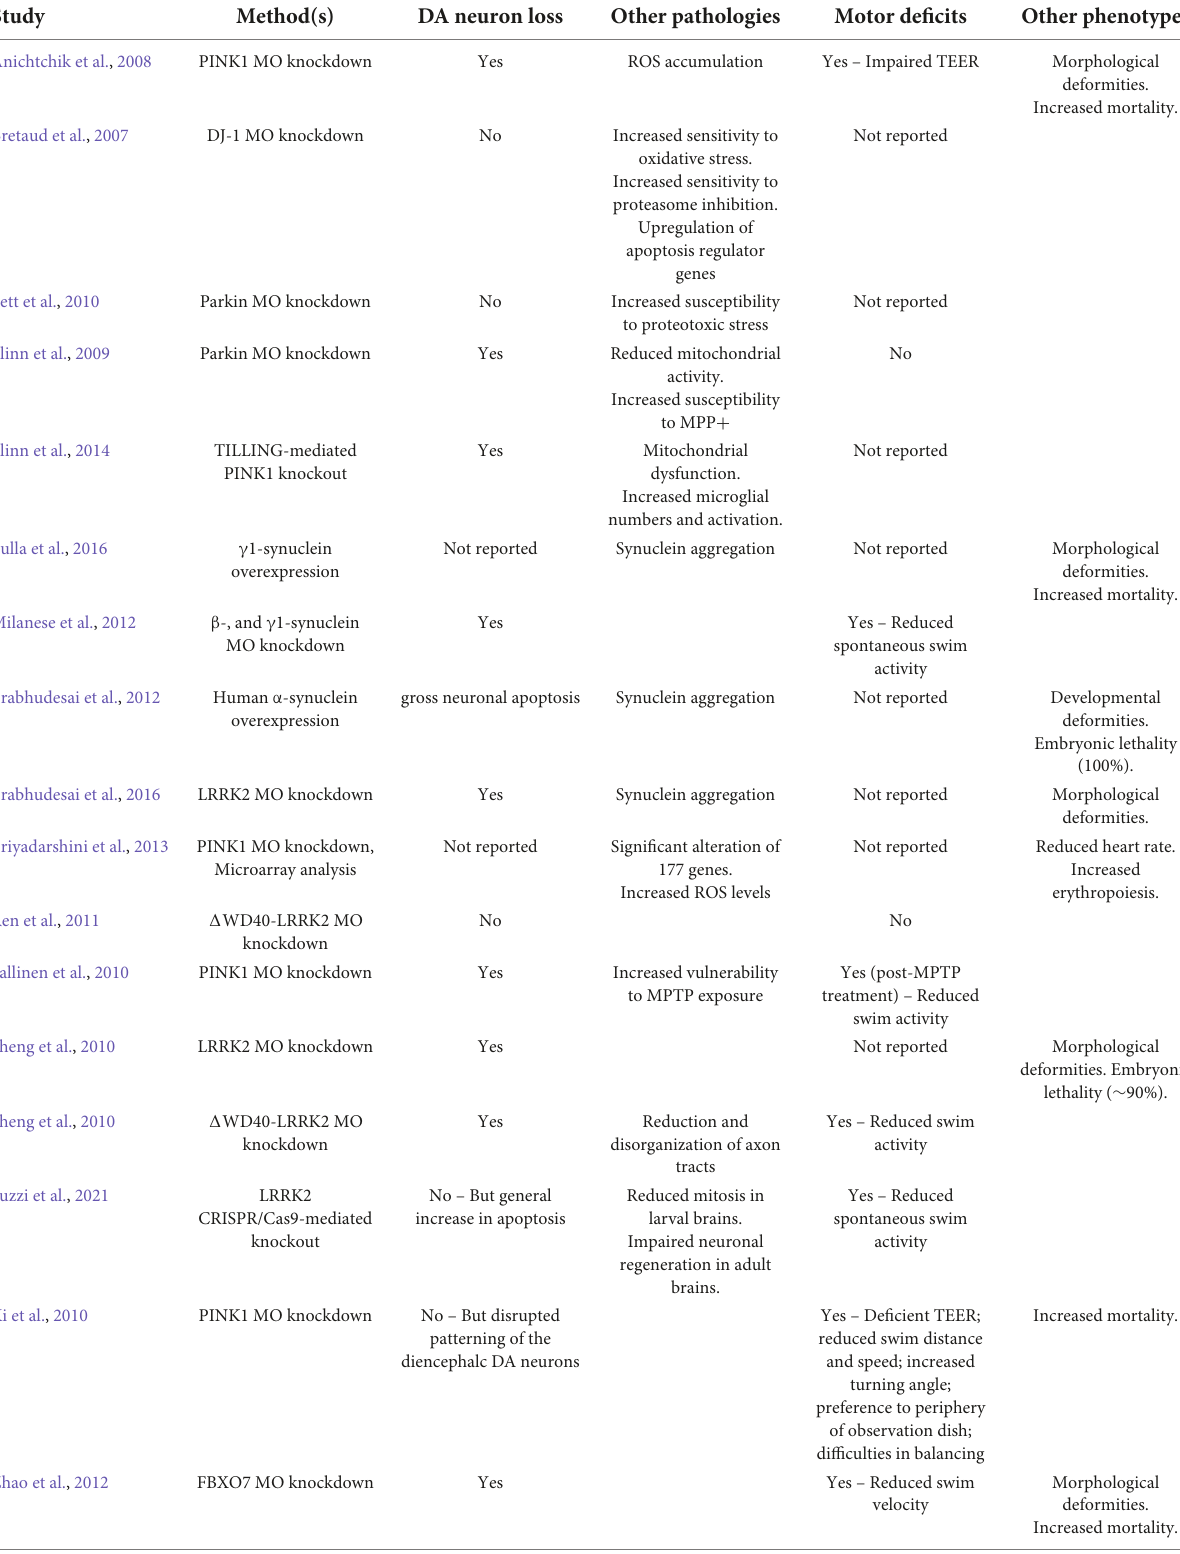
TABLE 1 Genetic zebrafish models of